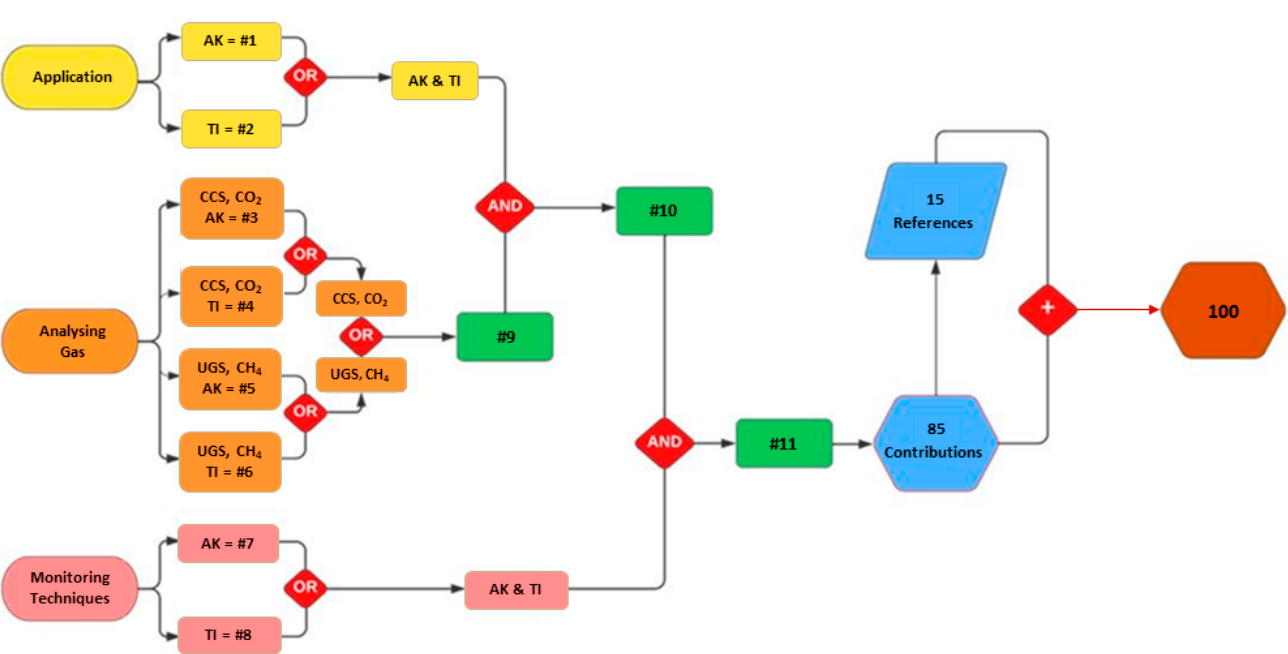
Figure 4. Structure of data collection criteria used to extract all the contributions about the research topic.